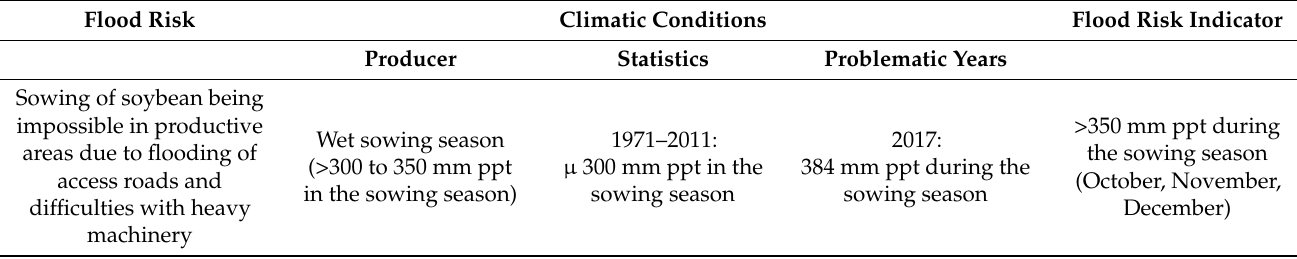
Table 1. Climatic conditions supplied by producers and assessed using historical precipitation observations for the impact of slow-onset floods on soybean production in the PGJdM, whereby µ stands for mean and ppt stands for precipitation. Flood Risk Climatic Conditions Flood Risk Indicator